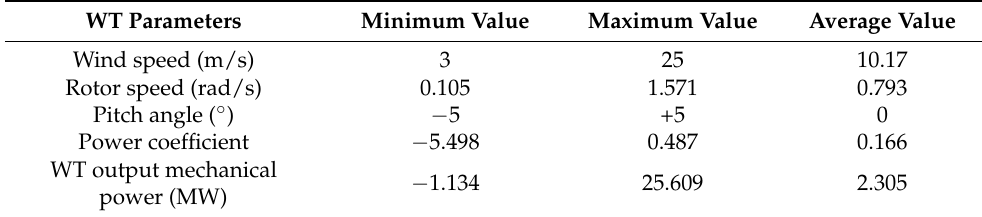
Table 2. WT data